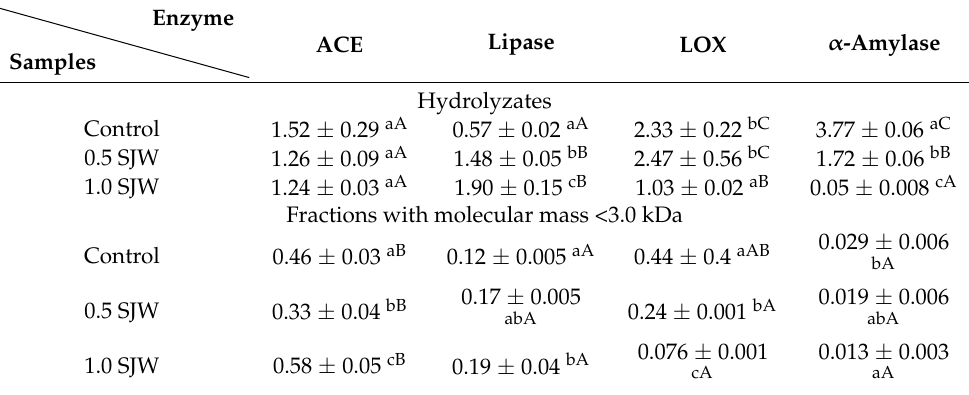
Table 5. Hydrolyzates and fractions with molecular mass <3.0 kDa as inhibitors of enzymes involved in metabolic syndrome (EC 50 mg mL − 1